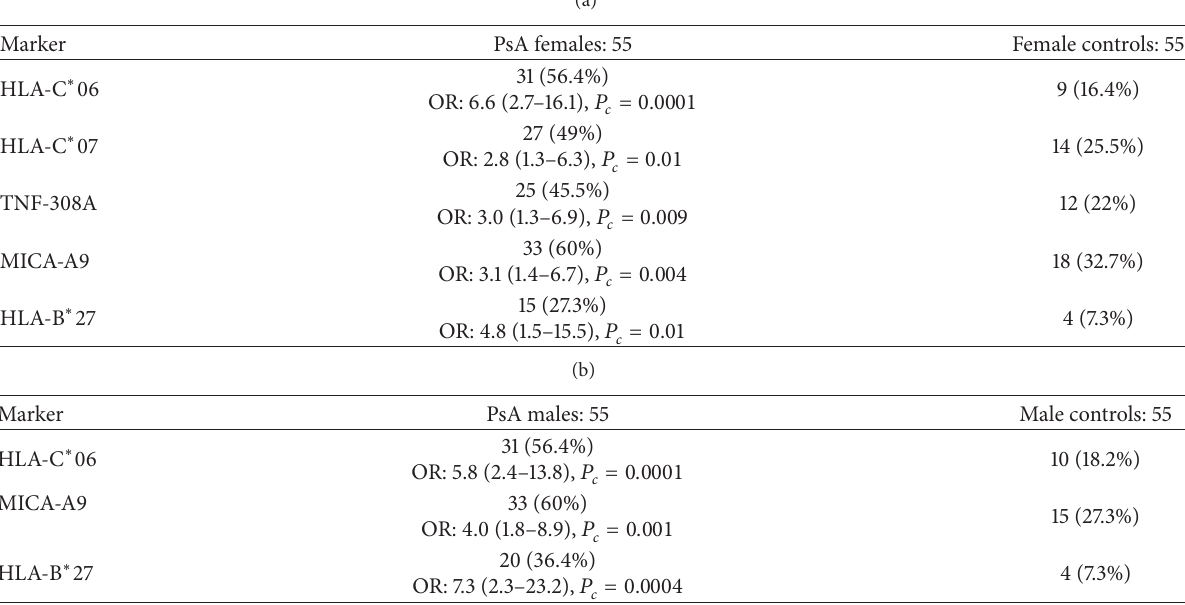
Table 3: Distribution of most significant markers in men and women with PsA.